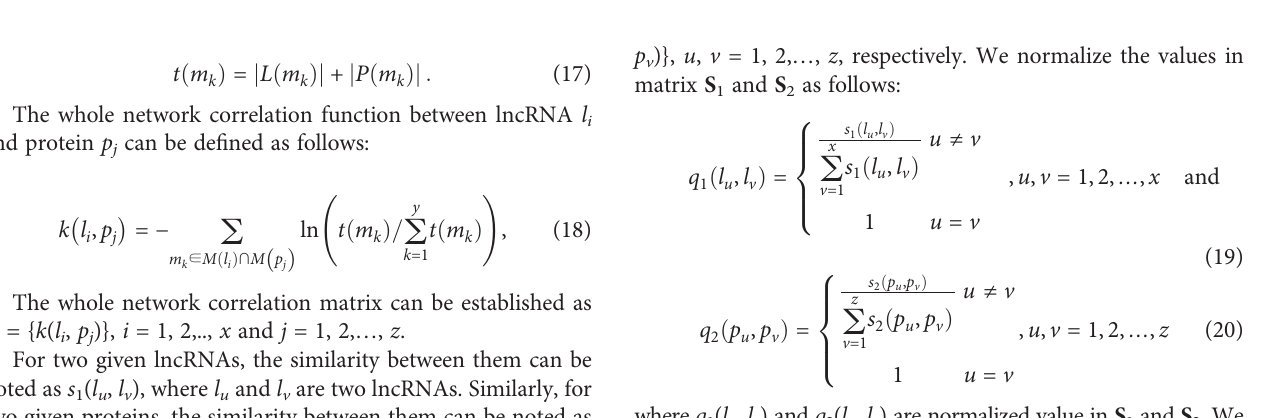
FIGURE 3 | A part of the lncRNA – miRNA – protein association network. Five proteins, 15 miRNAs, and 24 lncRNAs formed this part of the interaction network. Every miRNA can interact with multiple lncRNAs, and multiple proteins as